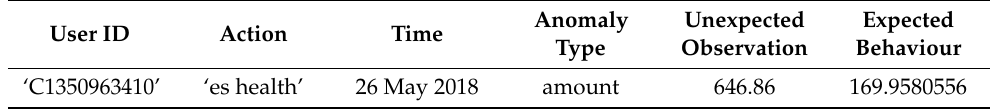
Table 2. Details of BankSim’s